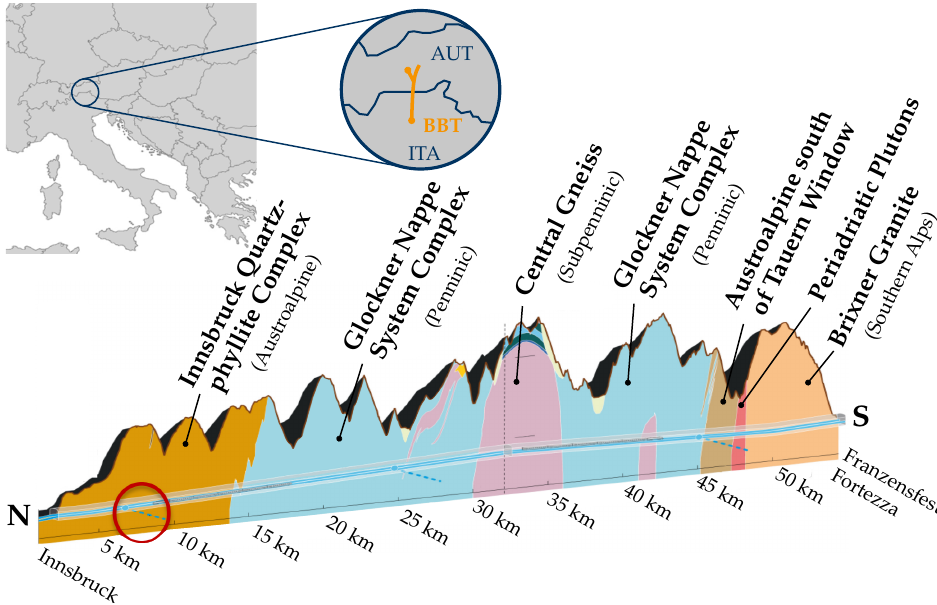
Figure 1. Geology of the Brenner Base Tunnel (BBT) from Innsbruck ( left ) to Franzensfeste/Fortezza ( right ) and location (red circle) of the considered stretch (adapted with permission from Ref. [45], 2019, BBT